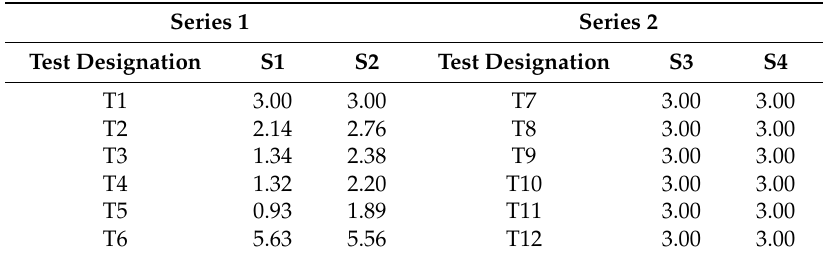
Table 2. The multiple of the stoichiometrically required amount of Ca 2+ ions in relation to the citrate concentration in the initial solutions S1, S2, S3, and S4